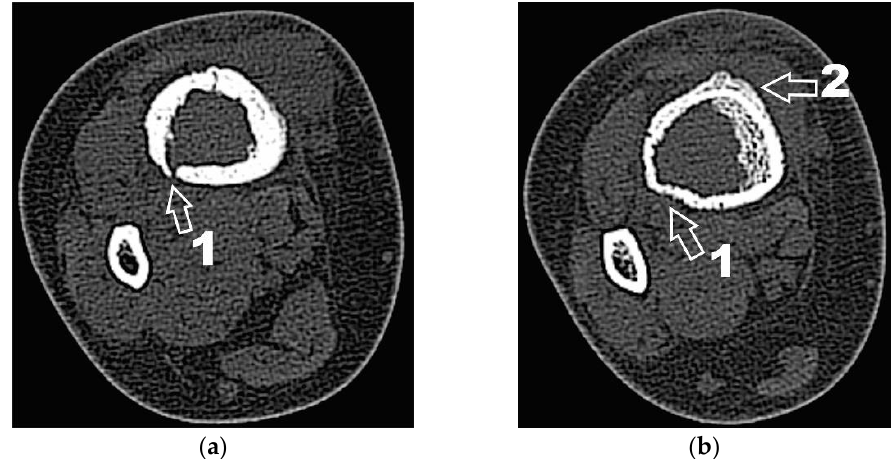
Figure 4. ( a ) CT axial section. 1 — disruption of the bone cortex; ( b ) CT axial section. 1 — thinning of bone cortex, 2 — periosteal reaction.